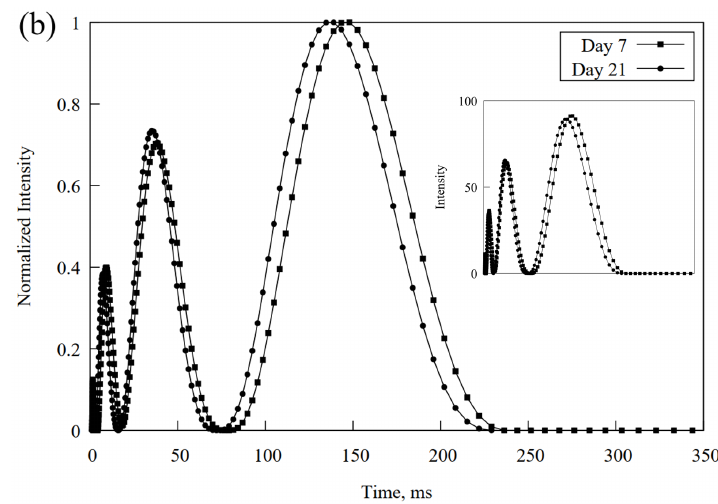
Figure 11. Relaxation time distribution (T 2 ) of Berea Sandstone saturated with brine for 21 days at 25 ◦ C. ( a ) 1% Na 2 SO 4 ; ( b ) 100% Na 2 SO 4